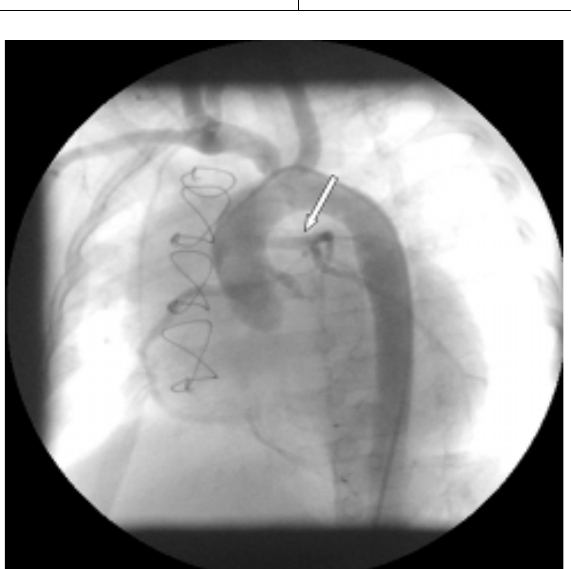
Fig. 1 - Cineangiocoronariografia no pós-operatório